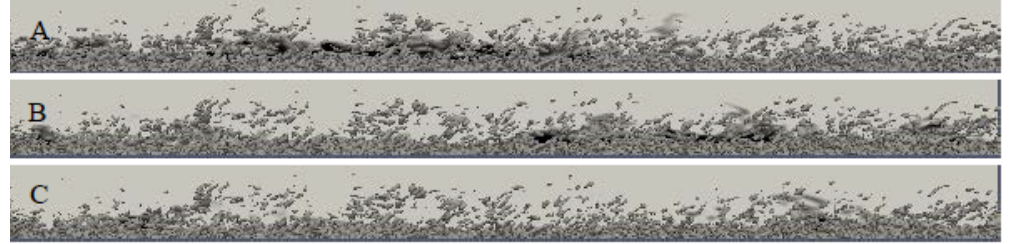
 in xz plane, the 2